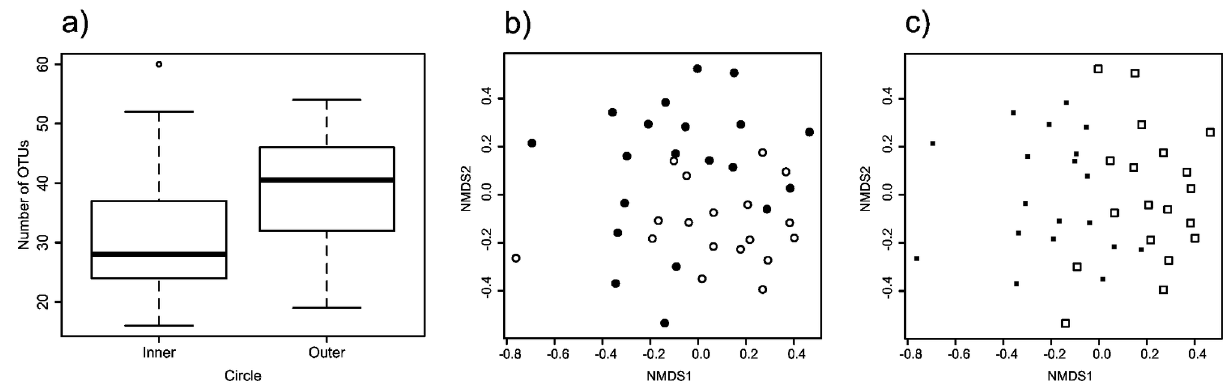
Figure 3. Boxplots showing non-ectomycorrhizal (non-EM) fungal diversity recovered from 160 pooled ingrowth bags collected around 20 isolated Pinus muricata trees of two different ages. a) More non-EM OTUs were found in outer than inner circles ( P < 0.05). b) and c) NMDS ordination based on OTUs presence/absence; each point represents a set of four pooled ingrowth bags; open circles represent ingrowth bags from inner circles, closed circles outer circles, open squares old trees, and closed squares bags from young trees (stress = 0.27). doi: